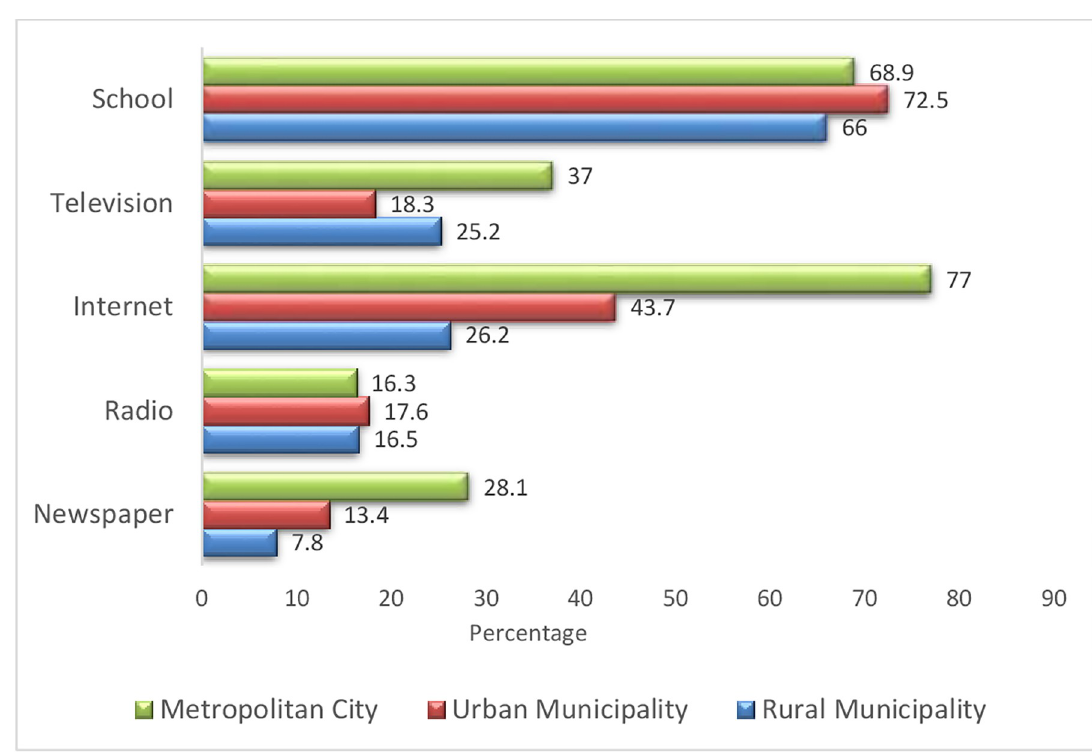
Fig 1. Sources of information on diabetes and